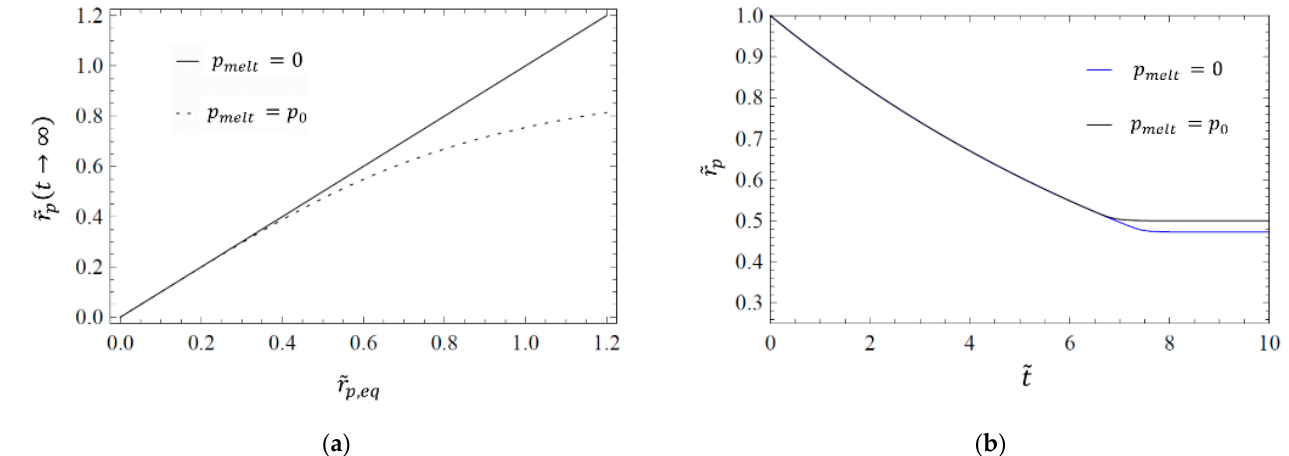
Figure 4. Comparison of the equilibrium radius 𝑟̃ (cid:3043),(cid:3032)(cid:3044) (at 𝑡 → ∞ ) as a function of the equilibrium value of the pore diameter ( a ) and the pore collapse dynamics ( b ), with and without consideration of the hydrodynamic ambient pressure acting on the surrounding melt 𝑝 (cid:2923)(cid:2915)(cid:2922)(cid:2930) . The parameters for both plots are 𝑟̃ (cid:3043),(cid:3032)(cid:3044) = 0.5 and 𝜆(cid:4634) = 5 .